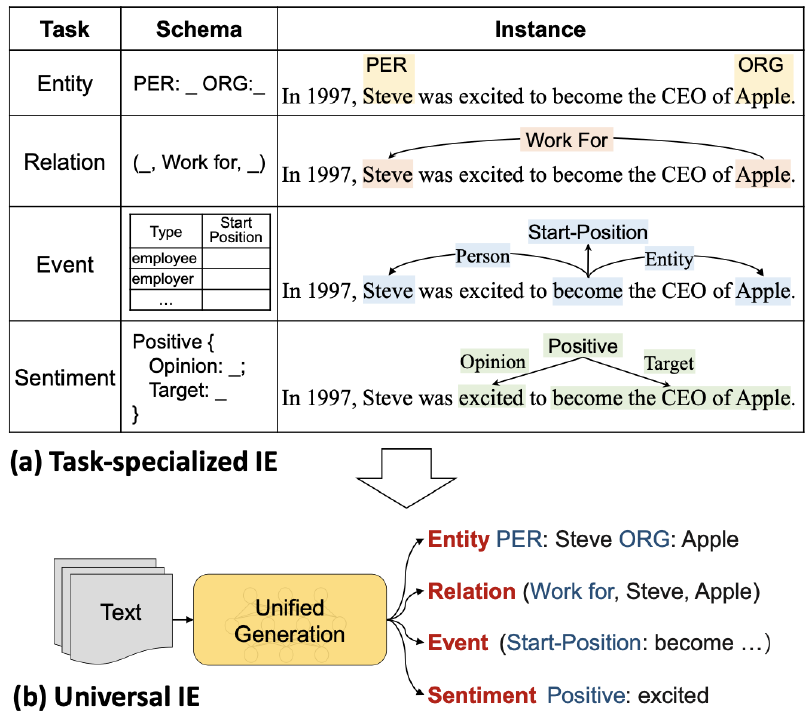
Figure 7. From ( a ) task-specialized IE: different tasks, different structures, different schemas to ( b ) universal IE: unified modeling via structure generation [80].